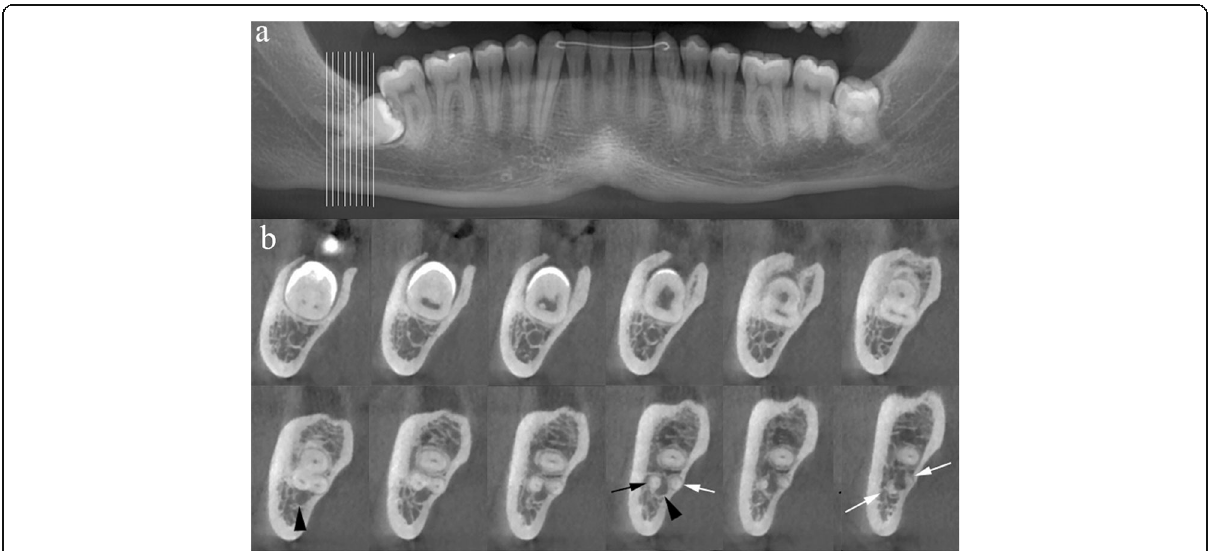
Fig. 15 Anatomical variant of nerve course. CBCT of the mandible, panorex reconstruction ( a ) indicating the range of the cross-sectional images in b . The roots (arrows) of the included right third molar encompass and remodel the mandibular canal (arrowheads), increasing the risk of nerve damage during tooth extraction